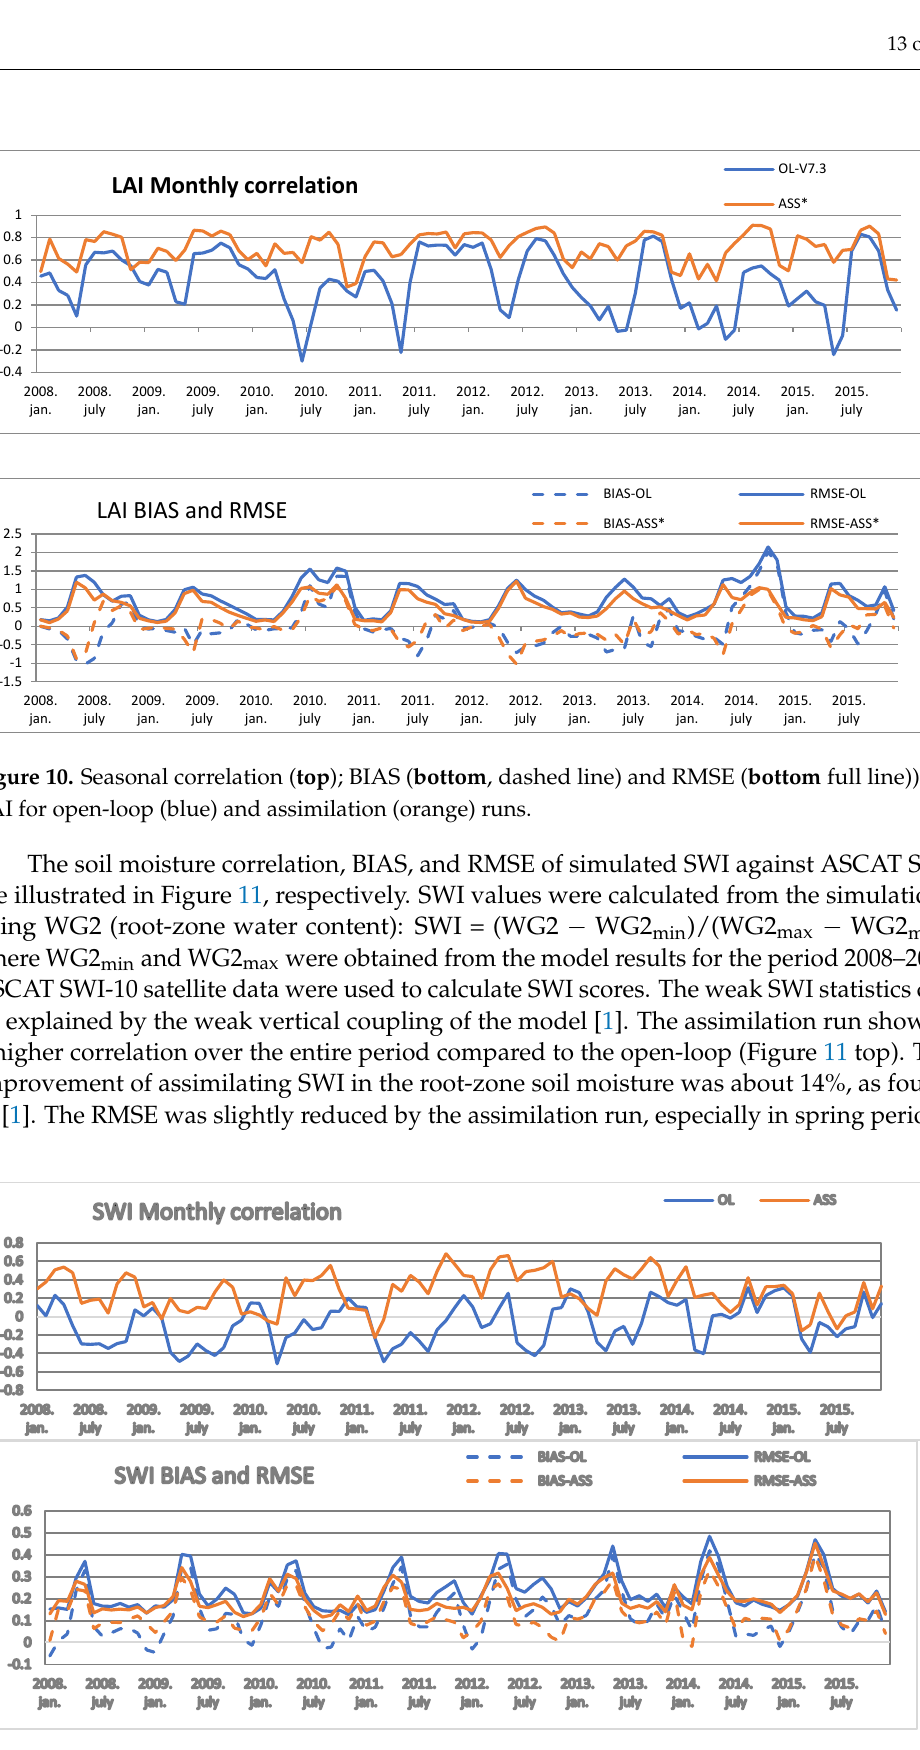
Figure 11. Seasonal correlation ( top ); BIAS (bottom, dashed line) and RMSE ( bottom , full line)) for SWI for open-loop (blue) and assimilation (orange) runs.